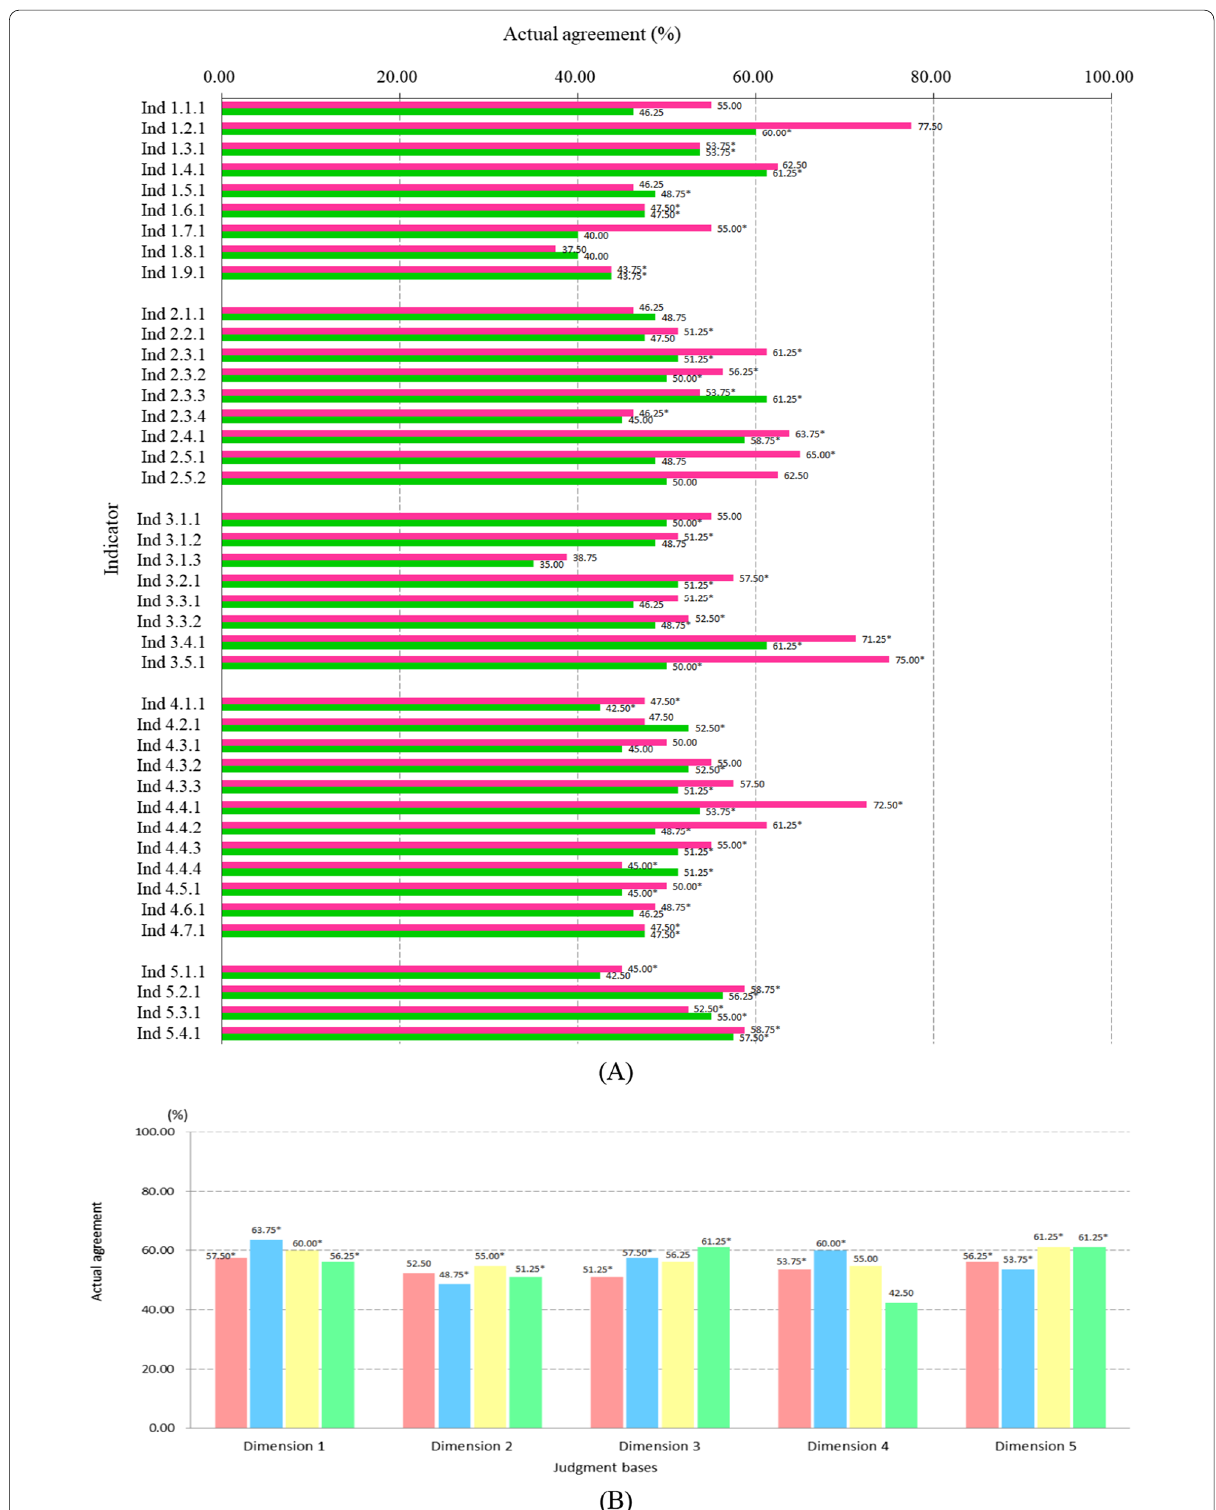
Fig. 4 Actual agreements of Kappa values for necessity, feasibility and judgment bases between two